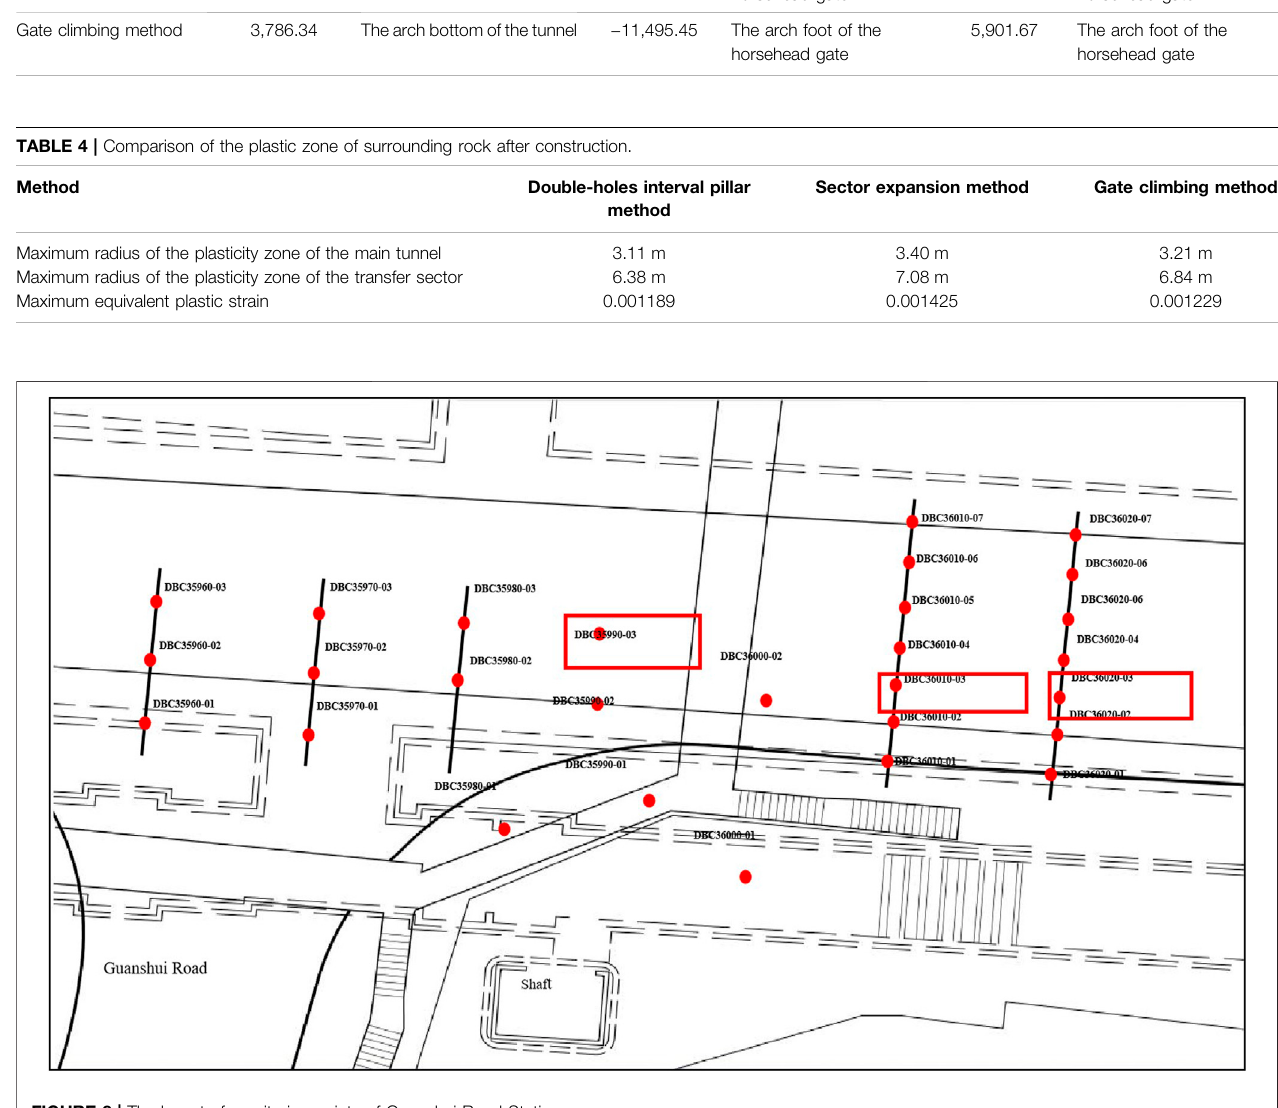
FIGURE 8 | The layout of monitoring points of Guanshui Road